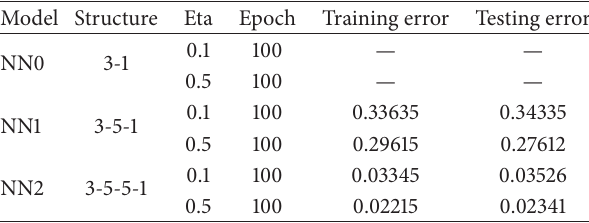
Table 7: Device error prediction